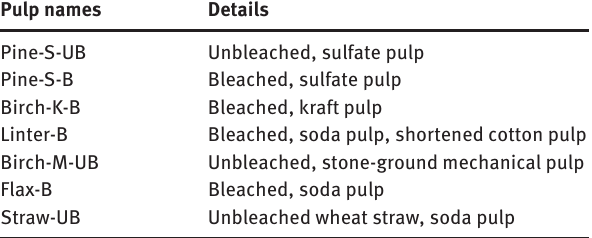
Table 1 Short names and detailed information of unbeaten pulps